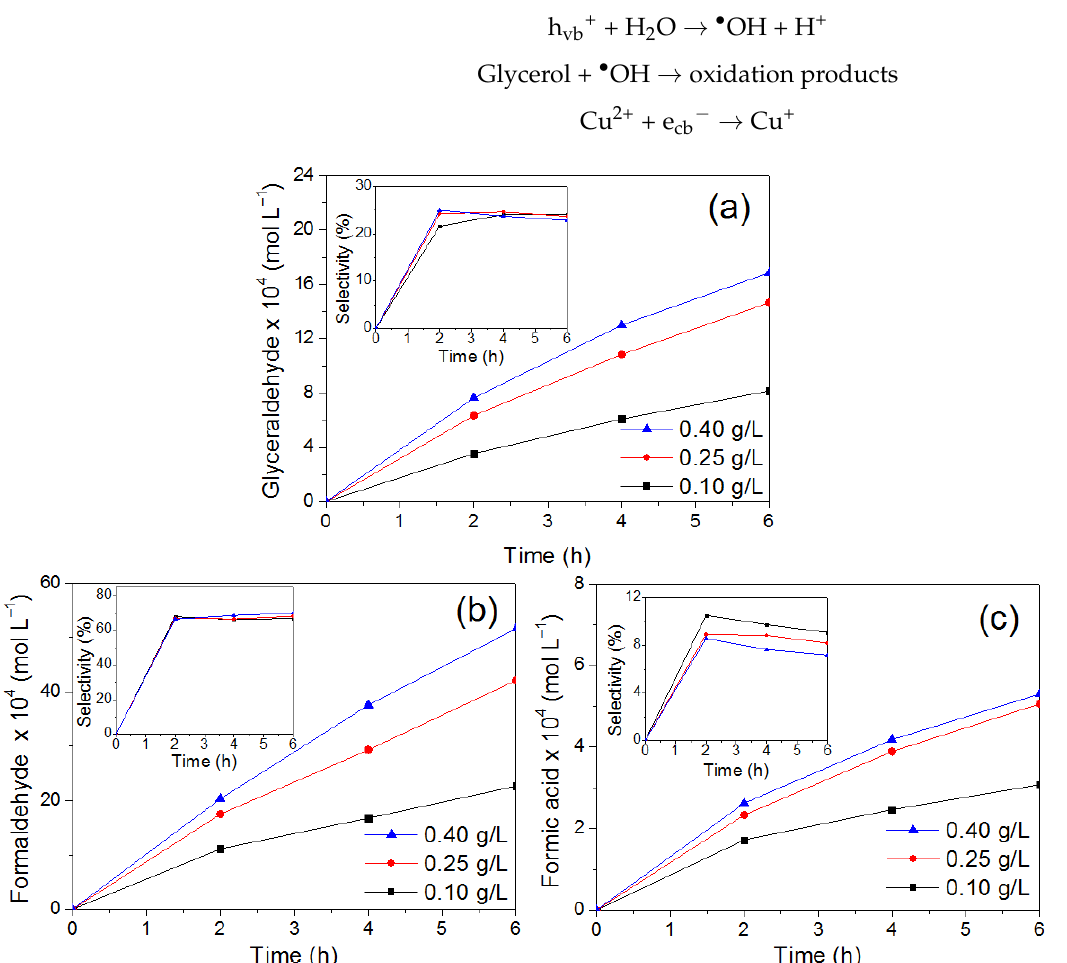
Figure 8. Effect of catalyst amount on concentration and selectivity towards ( a ) glyceraldehyde (GCD), ( b ) formaldehyde (FD), and ( c ) formic acid (FA). Initial glycerol = 6.25 × 10 −2 M, T = 305.65 K, Cu/TiO 2 catalyst.